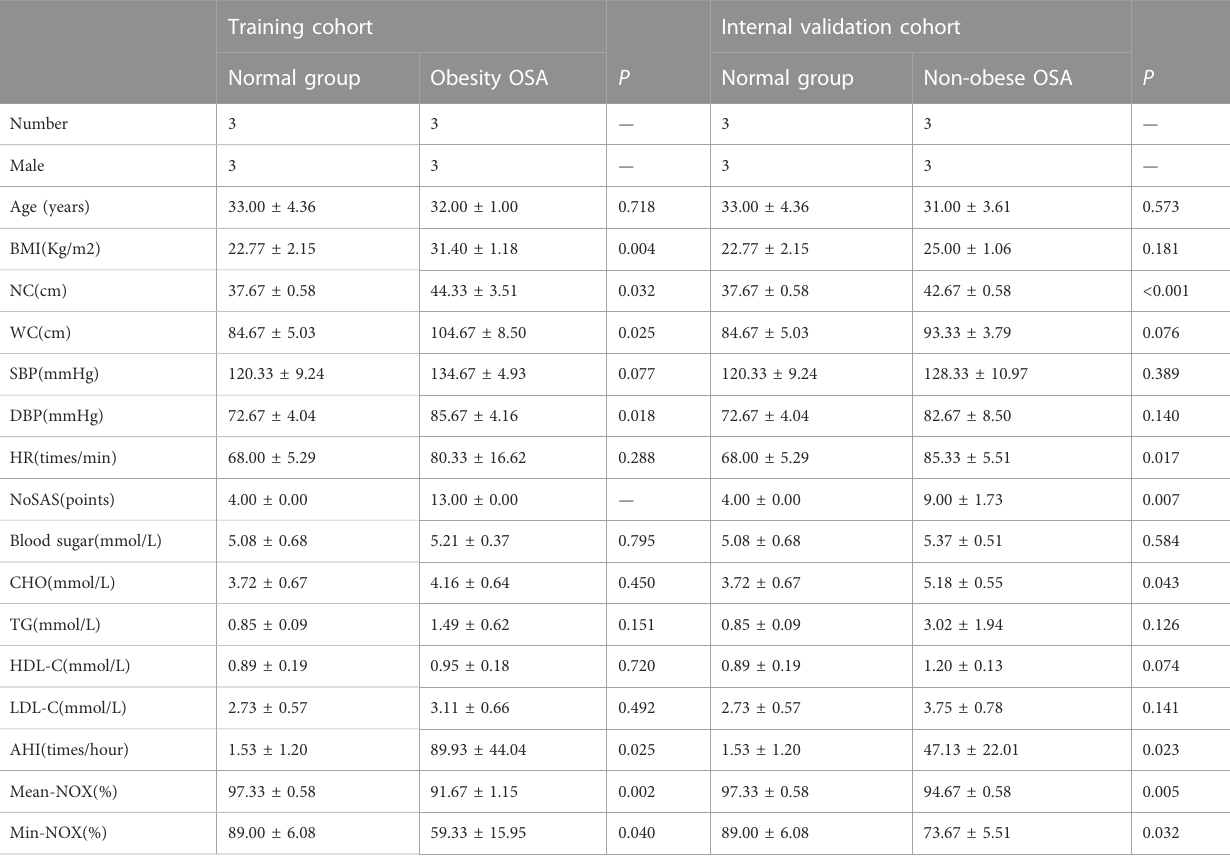
TABLE 1 Clinical characteristics of the study